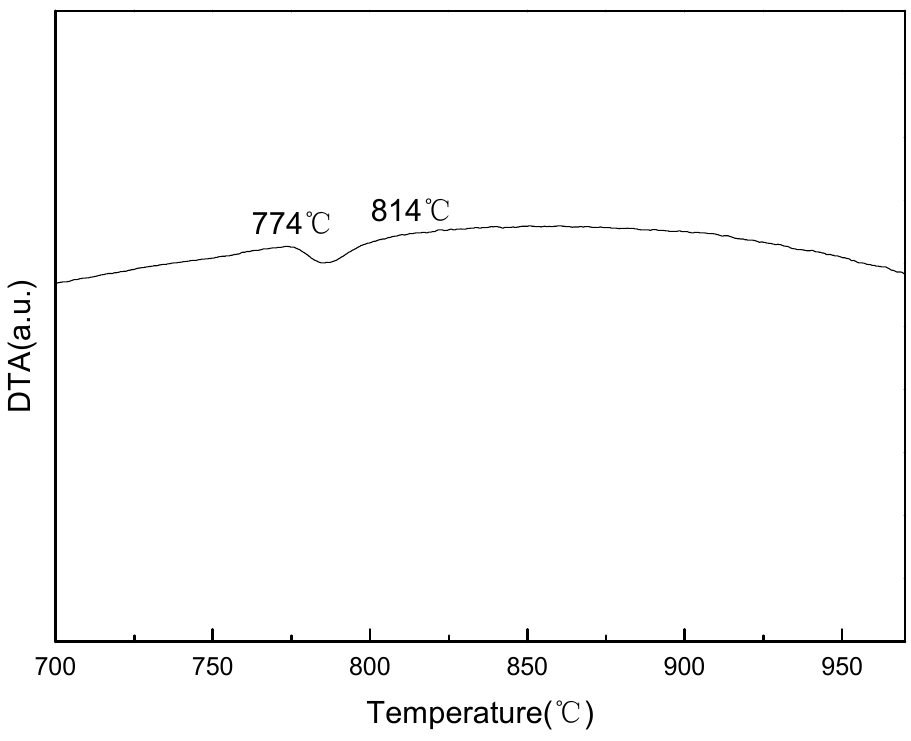
Figure 1. Differential thermal analysis (DTA) curve of the samples during the heating process. The temperature interval of the lattice transformation is about 774 °C – 814 °C.